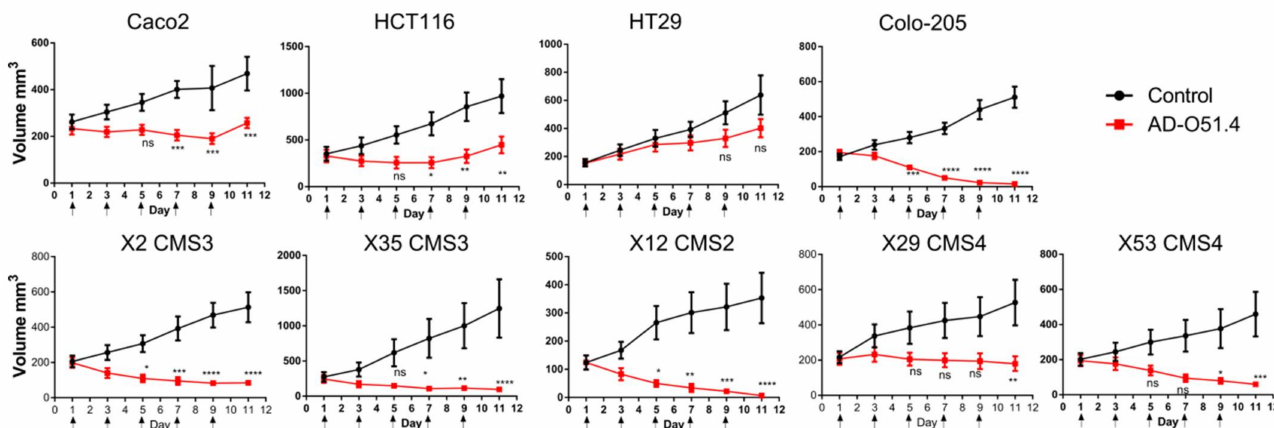
Figure 2. In vivo studies show the decreased growth of the colorectal cancer cell line and patient derived xenografts after AD-O51.4 treatment AD-O51.4 was intravenously administered five times every other day (arrows) at 50 mg/kg. CMSs 1–3 indicate one of the four consensus molecular subtypes (CMSs) of the colorectal cancer [31]. X2, X35, X12, X29 and X53 are internal IDs of patient-derived xenograft (PDX) models. Groups size n = 6, each mouse bearing one tumor, ± SEM. Differences between groups were evaluated using two-way repeated measures ANOVA; * p < 0.05, ** p < 0.01, *** p < 0.001, **** p < 0.0001; ns—not significant.